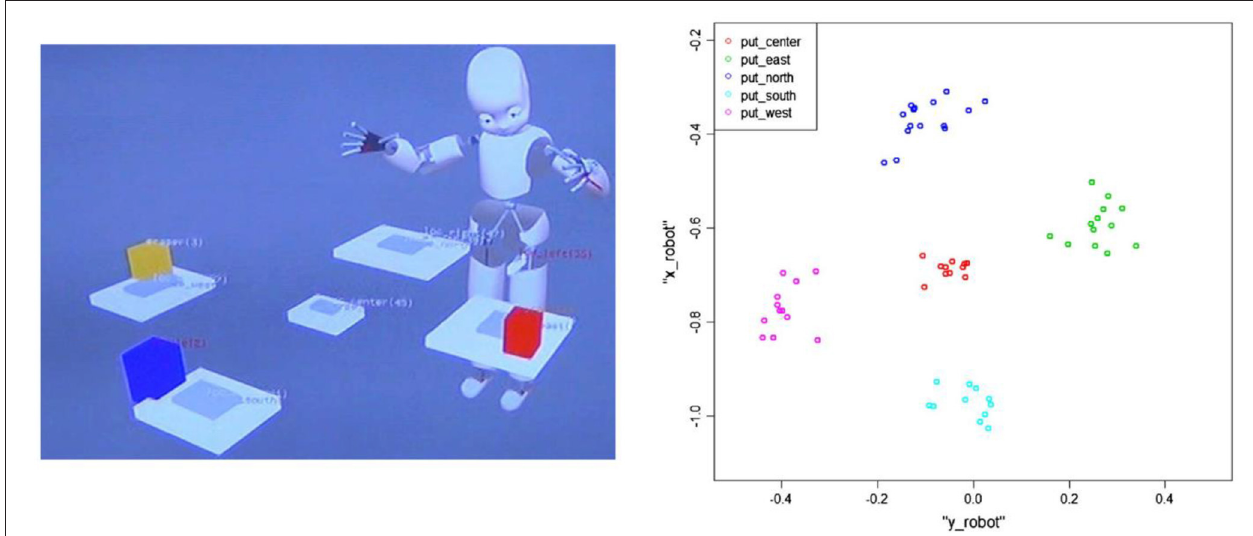
FIGURE 3 | Results of learning spatial locations and actions. (Left) iCub’s internal representation of learned locations in its working memory, the Object Property Collector (OPC). Gray boxes correspond to learned spatial locations, and colored boxes correspond to recognized objects on the table. (Right) Clustering of spatial locations associated with 5 named locations in the ABM that allow learning of the generalized location associated with each